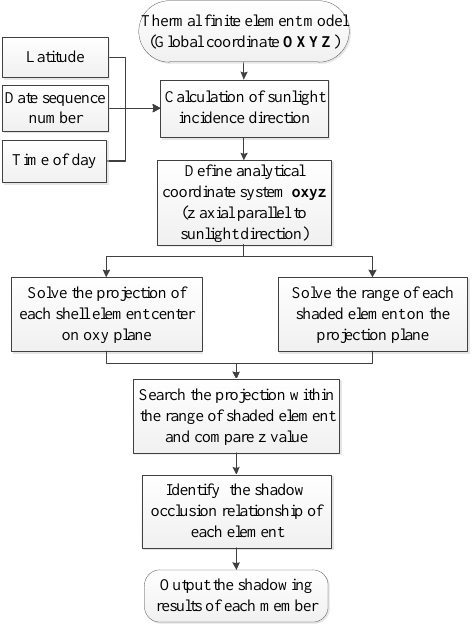
Figure 8. Flow chart of shadow analysis.